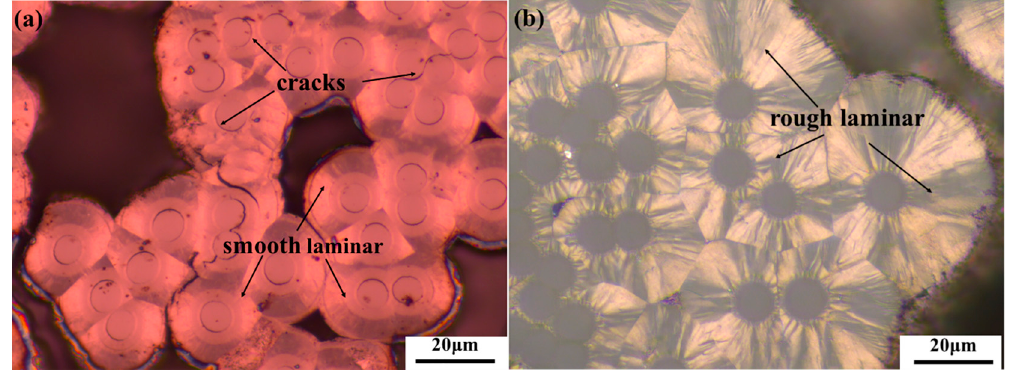
Figure 5. Polarized light microscopy images of the ( a ) C/C and ( b ) C/G/C composites.